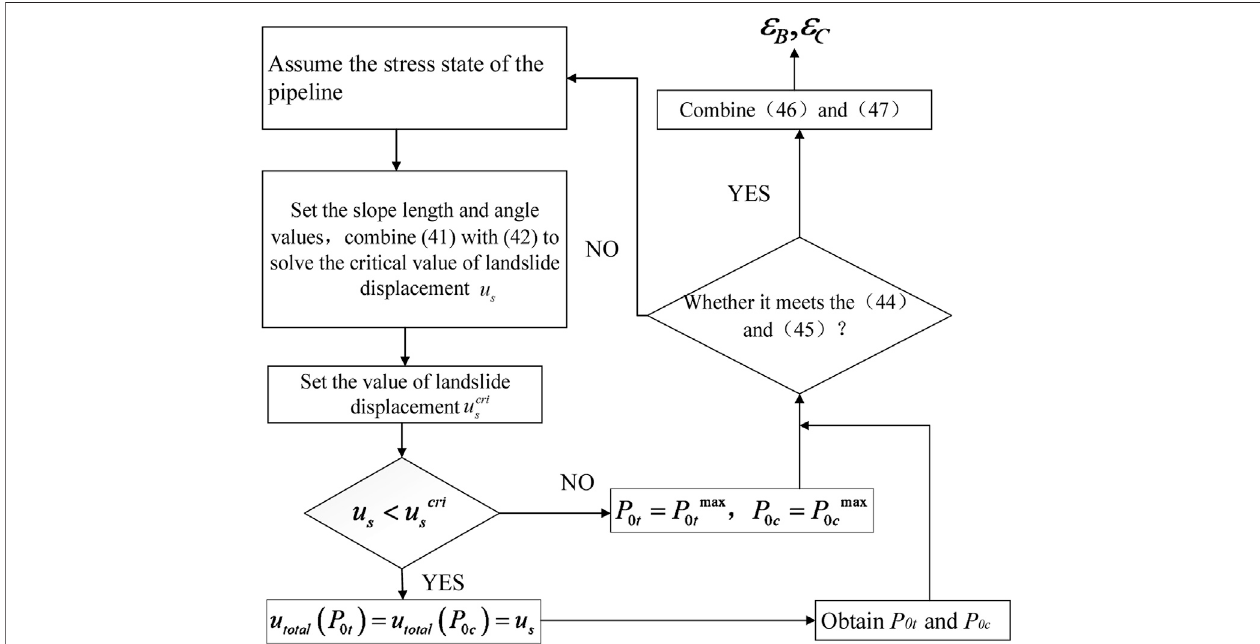
FIGURE 10 | Steps for solving the maximum longitudinal strain of the pipeline at points B and